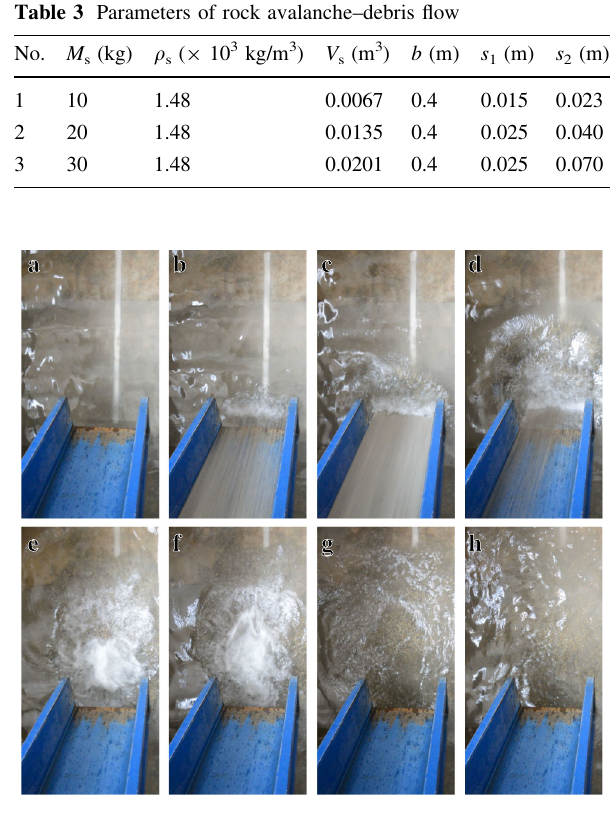
Rock avalanche–debris flow